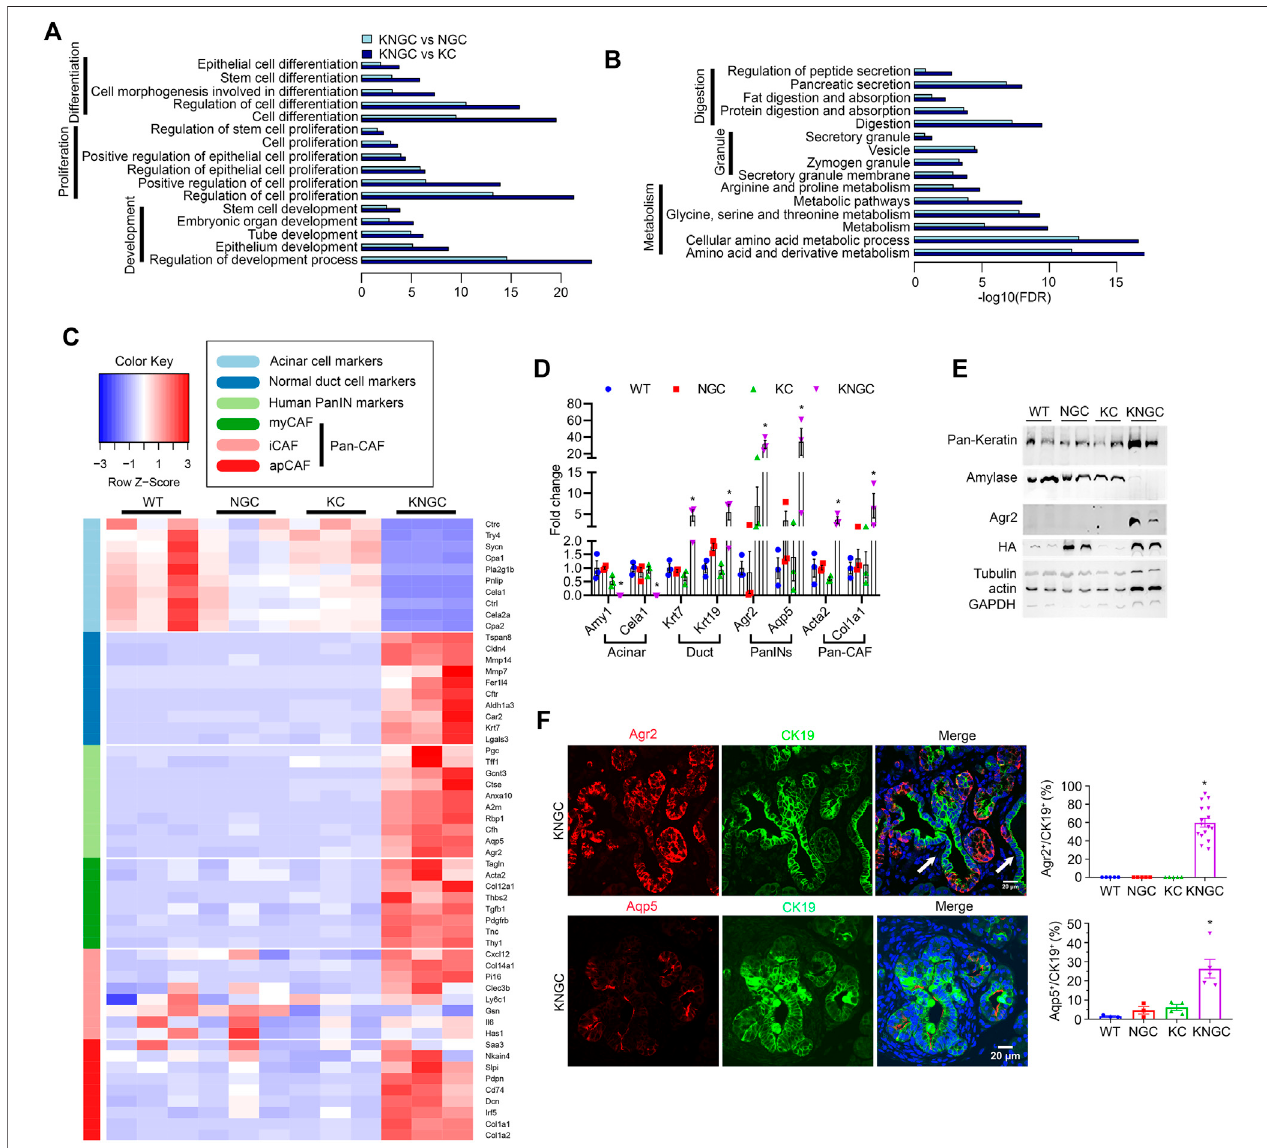
FIGURE 2 | Transcriptional regulation of pancreatic ductal neoplasia by nuclear GSK-3 β and Kras G12D . (A) KEGG cellular processes enriched for genes with increased expression in KNGC mice compared with NGC or KC. (B) KEGG cellular processes enriched for genes with decreased expression in KNGC mice compared with NGC or KC. (C) Heatmap was generated for selected gene sets related to the indicated groups using normalized gene expression. Colors are assigned based on raw z-scores. (D) Real-time PCR quanti fi cation of the indicated genes from 4-week-old WT, NGC, KC or KNGC mice. Data were analyzed and expressed as mean±SEM. n =3. p p < 0.05KNGC mice versustheother genotypes. (E) Cell lysates from pancreas of4-week-old WT,NGC, KCand KNGC mice were prepared and probed with the indicated antibodies. Shown are representative results from three experiments. (F) Immuno fl uorescence staining of Agr2 (red, top), Aqp5 (red, bottom) and CK19 (green) from pancreatic sections of 4-week-old KNGC mice. White arrow indicated Agr2 − (top) and Aqp5 − (bottom)/CK19 + cells. And quanti fi cation of Agr2 + and Aqp5 + percentage in CK19 cells was analyzed and expressed as mean ± SEM. p p < 0.05 KNGC mice versus the other genotypes.